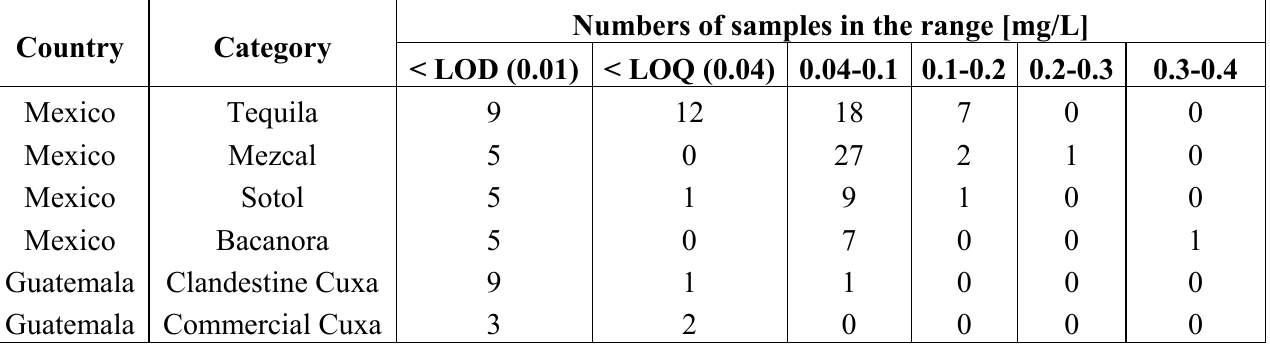
Table 1. Incidence of ethyl carbamate contamination in alcoholic beverages from Mexico and